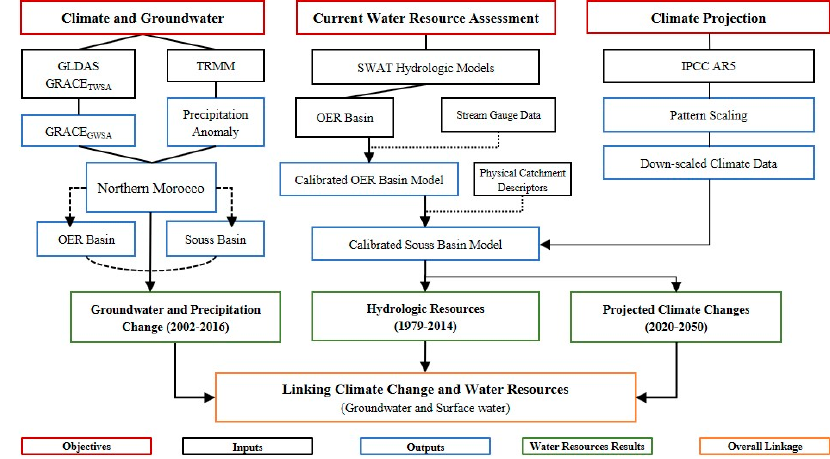
Figure 2. Overall objectives and methodology workflow.